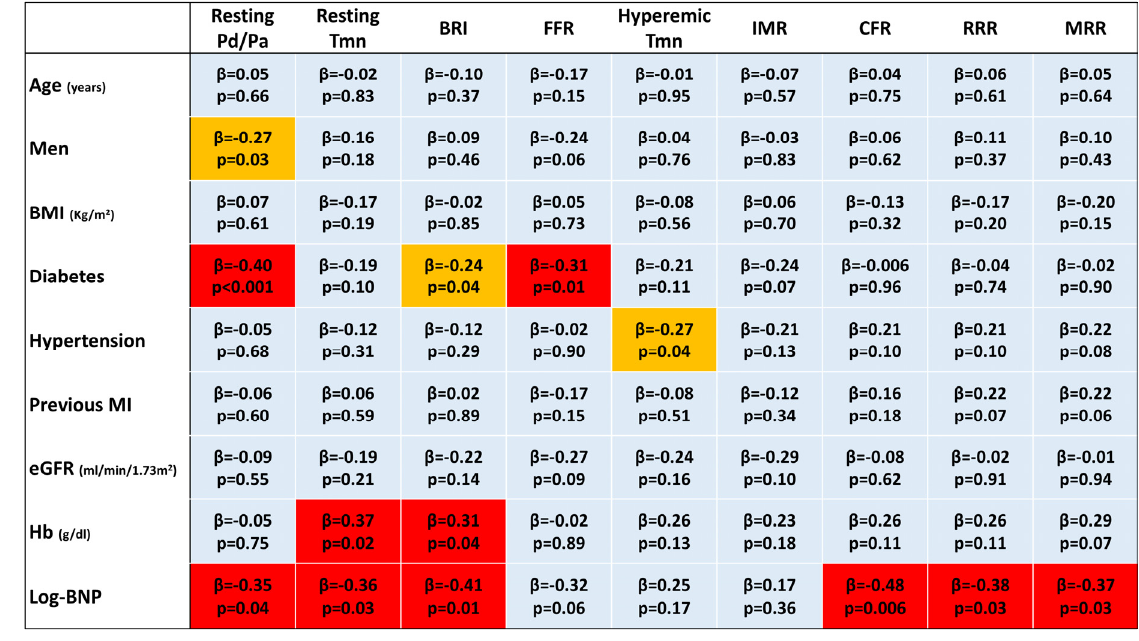
Figure 7. A heat map for multivariable linear regression analyses in cases in which papaverine was used as a hyperemic agent. A cell in light blue indicates no significant association ( p ≥ 0.05). When significant associations are found ( p < 0.05), cells are displayed in light ( − 0.20 ≤ β ≤ 0.20) or warm yellow ( − 0.30 ≤ β < − 0.20 or 0.20 < β ≤ 0.30) or red ( β < − 0.30 or β > 0.30). BMI, body mass index; BNP, brain natriuretic peptide; BRI, baseline resistance index; CFR, coronary flow reserve; eGFR, estimated glomerular filtration rate; FFR, fractional flow reserve; IMR, index of microcirculatory resistance; MI, myocardial infarction; MRR, microvascular resistance reserve; Pd/Pa, ratio of distal coronary pressure to aortic pressure; RRR, resistive reserve ratio; Tmn, mean transit time.